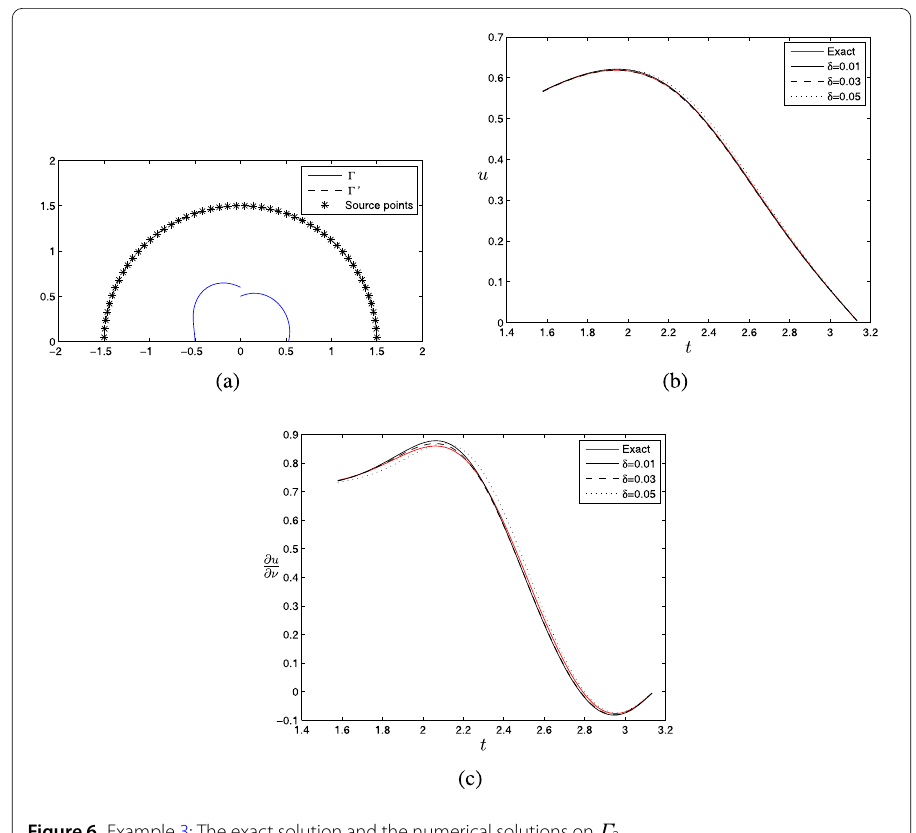
Figure 6 Example 3: The exact solution and the numerical solutions on Γ 2